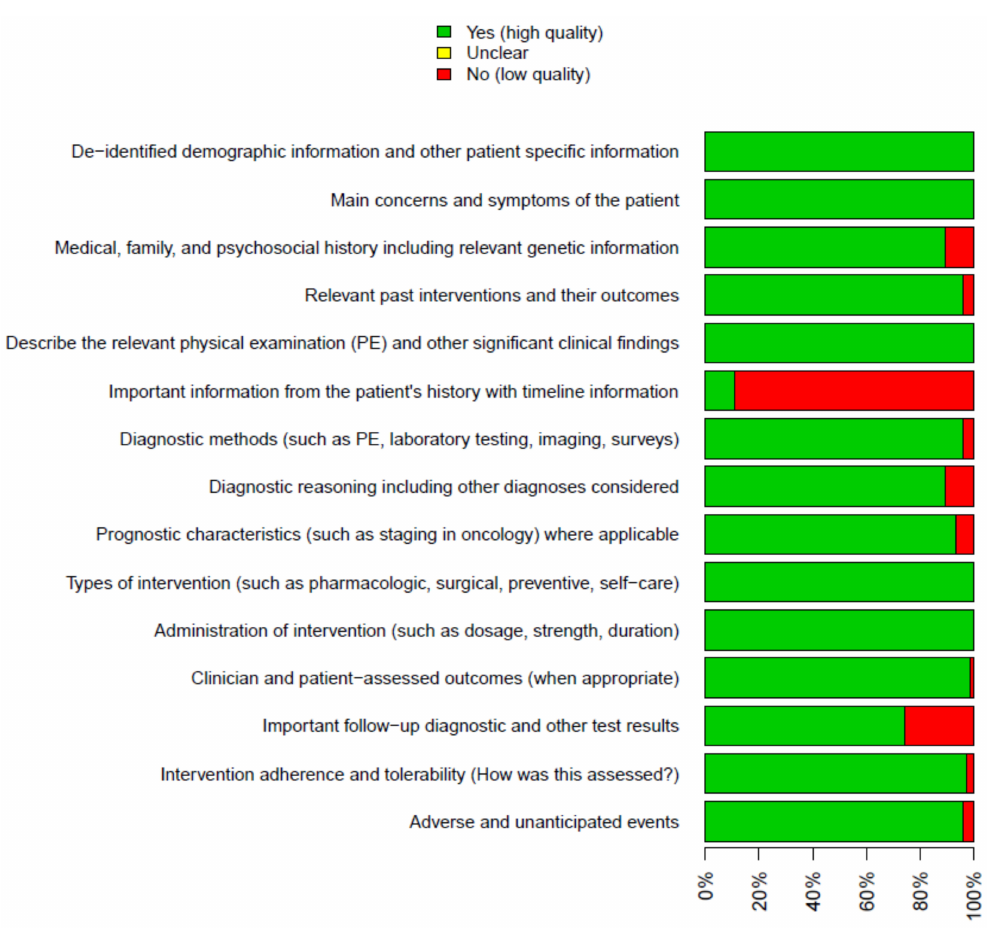
Figure 2. Methodological quality summary, considering all included studies in this meta-analysis and each specific methodological quality